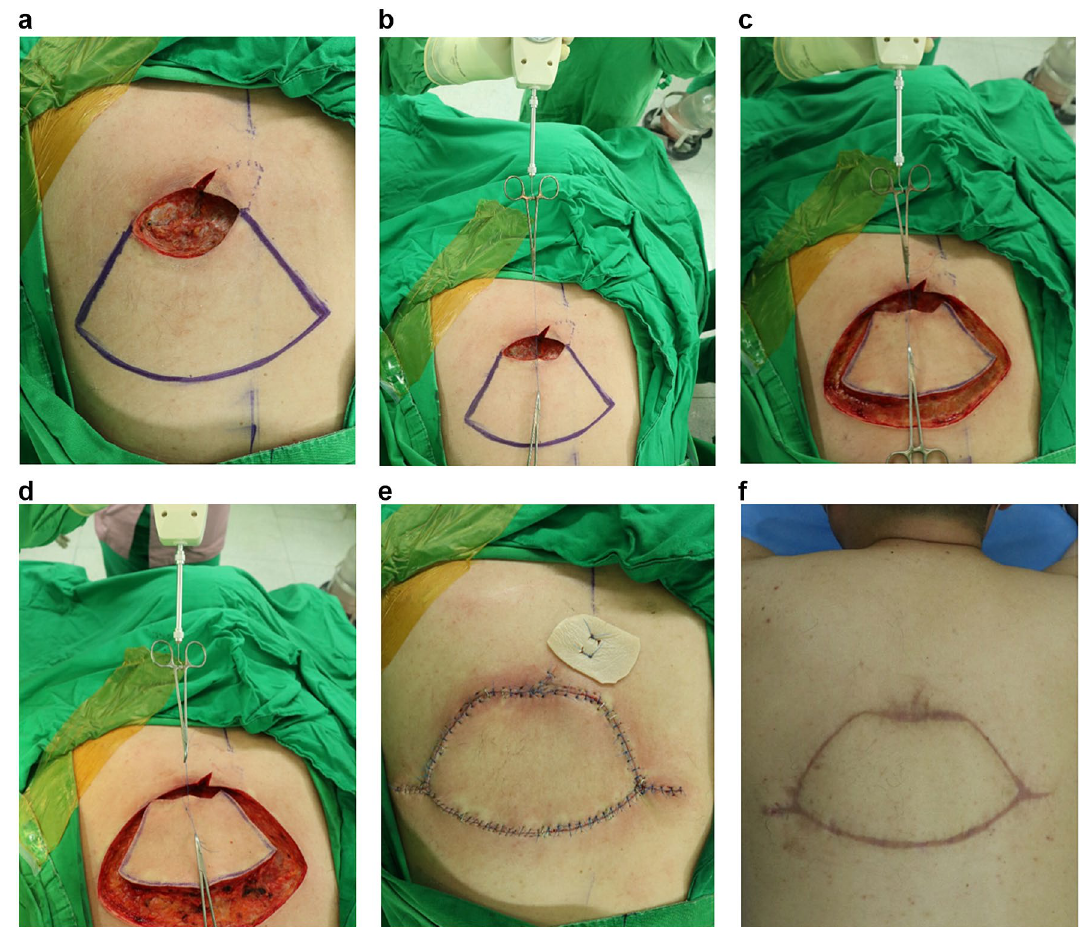
Figure 4. Keystone perforator island flap (KPIF) coverage for a defect that resulted from complete excision of a ruptured epidermoid cyst with cellulitis in a 42-year-old man. ( a ) After complete excision and debridement of the lesion in the upper left back, the final defect size is 6 × 8 cm. We designed an 8 × 18 cm-sized KPIF in the lower side of the defect. ( b ) Before performing skin incisions, the “pre-flap tension at the defect” is measured and recorded. ( c ) After the release of the thick dermis and subcutaneous tissues, with no division of the deep fascia, “Type I KPIF tension at the defect” is measured and recorded. ( d ) After the division of the deep